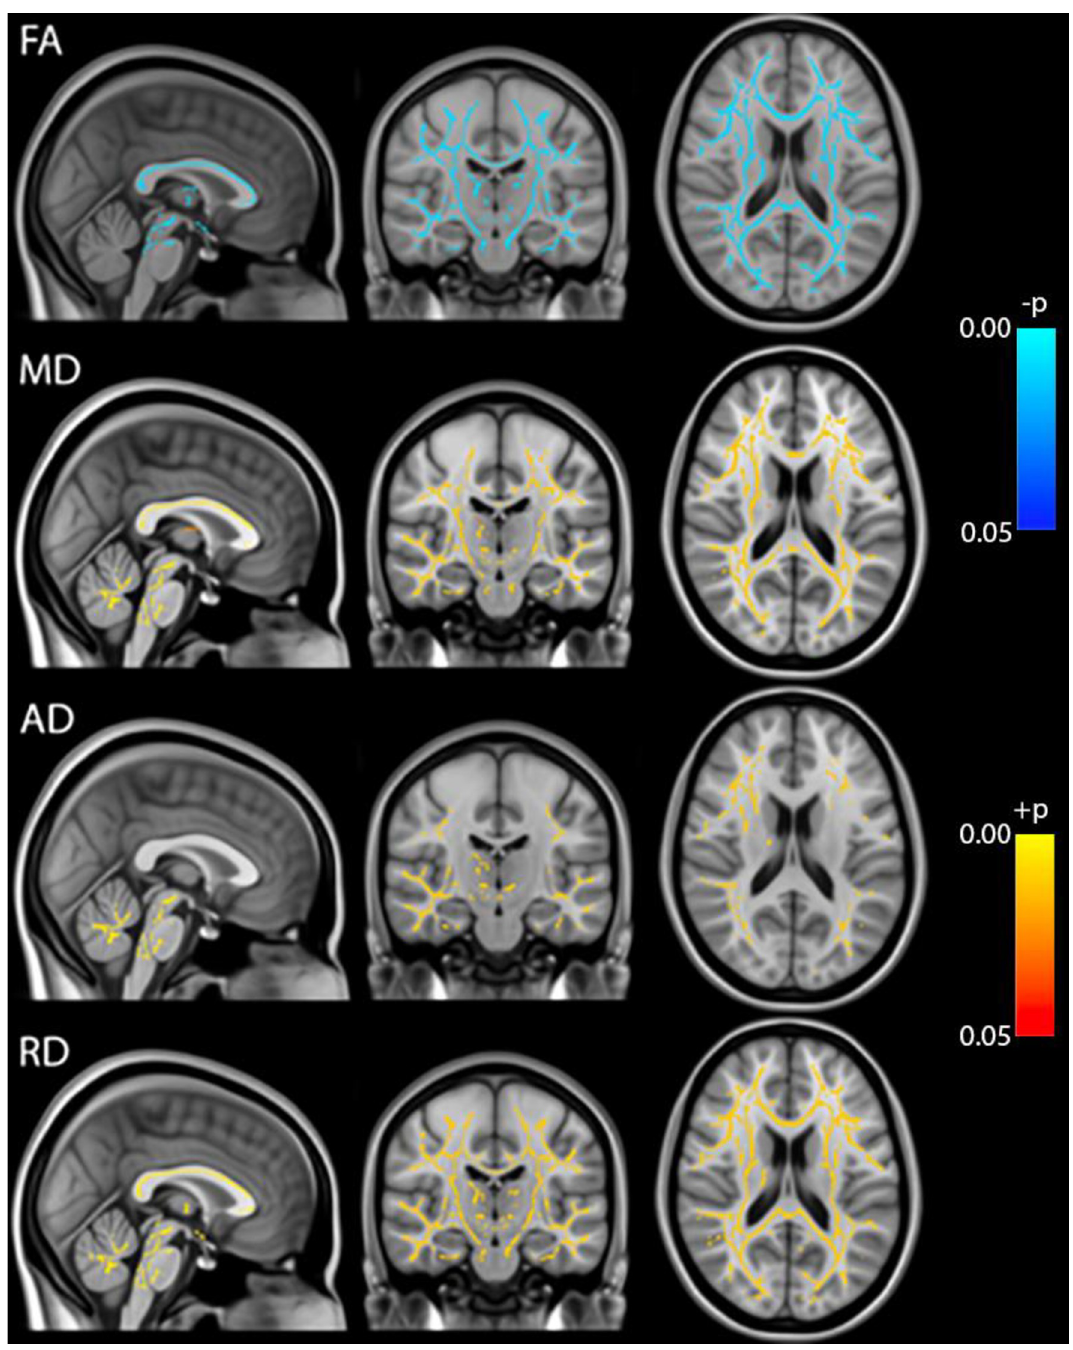
Fig 1. TBSS analysis of DTI metrics (FA, MD, AD, RD). Blue: Pre-anesthesia > during anesthesia, Red: Pre-anesthesia < during anesthesia, p < 0.05 FWE-corrected. Similarly, there was no significant association between change in FA and sex ( β = -0.000178; 95% CI: -.002184 to 0.001827; p = 0.86) after controlling for age and baseline FA. No signifi- cance associations were found between changes in MD, AD and RD and age or sex (Tables 2 and 3).